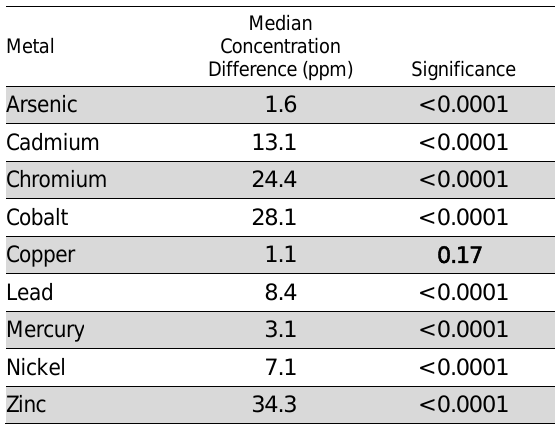
Table 3. Median Concentration